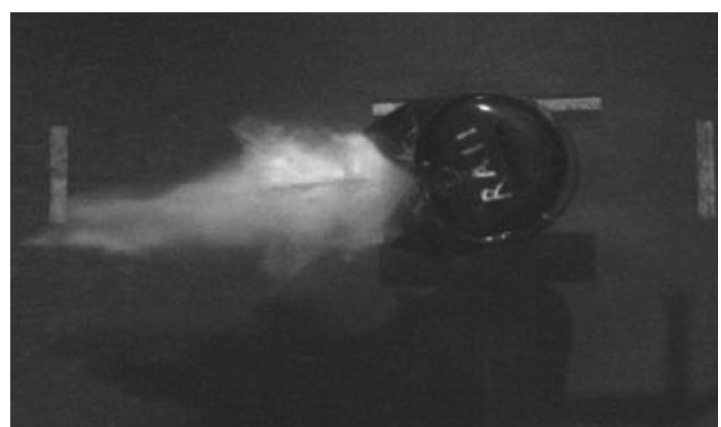
Fig. 1. Overview of the test setup.